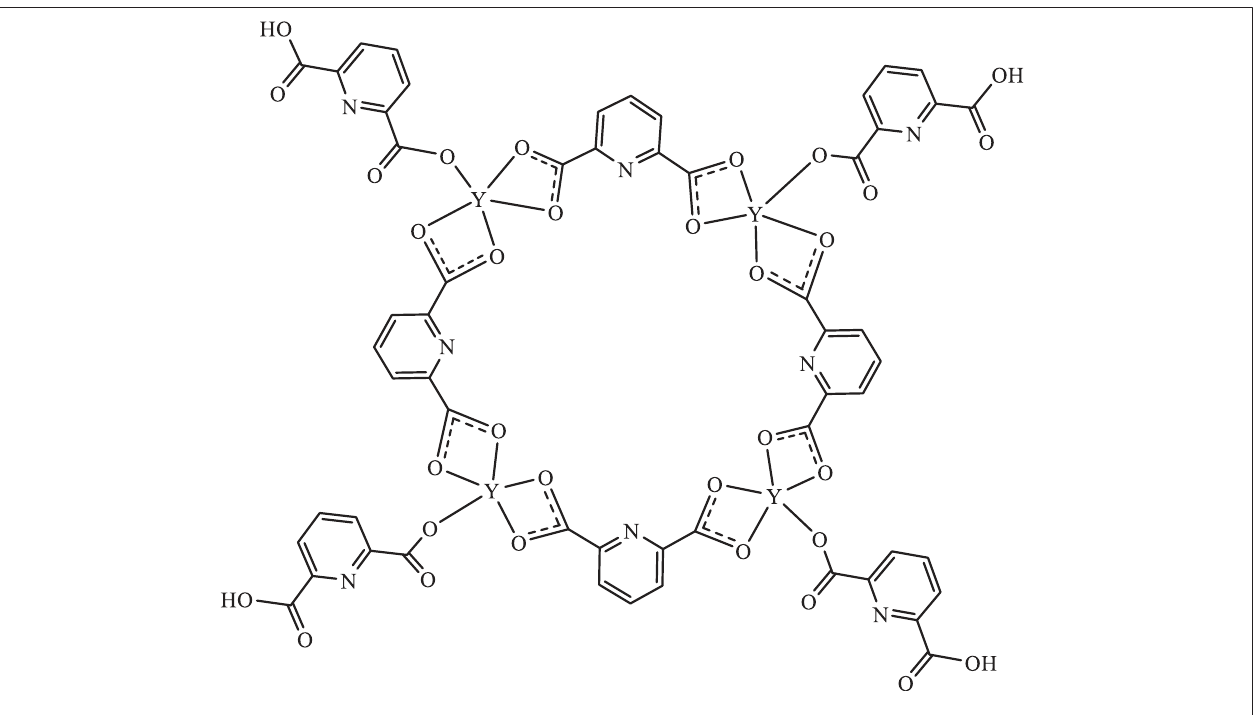
FIGURE 6 | Proposed structures of Y-MOF synthesized under the optimal condition of the microwave route.